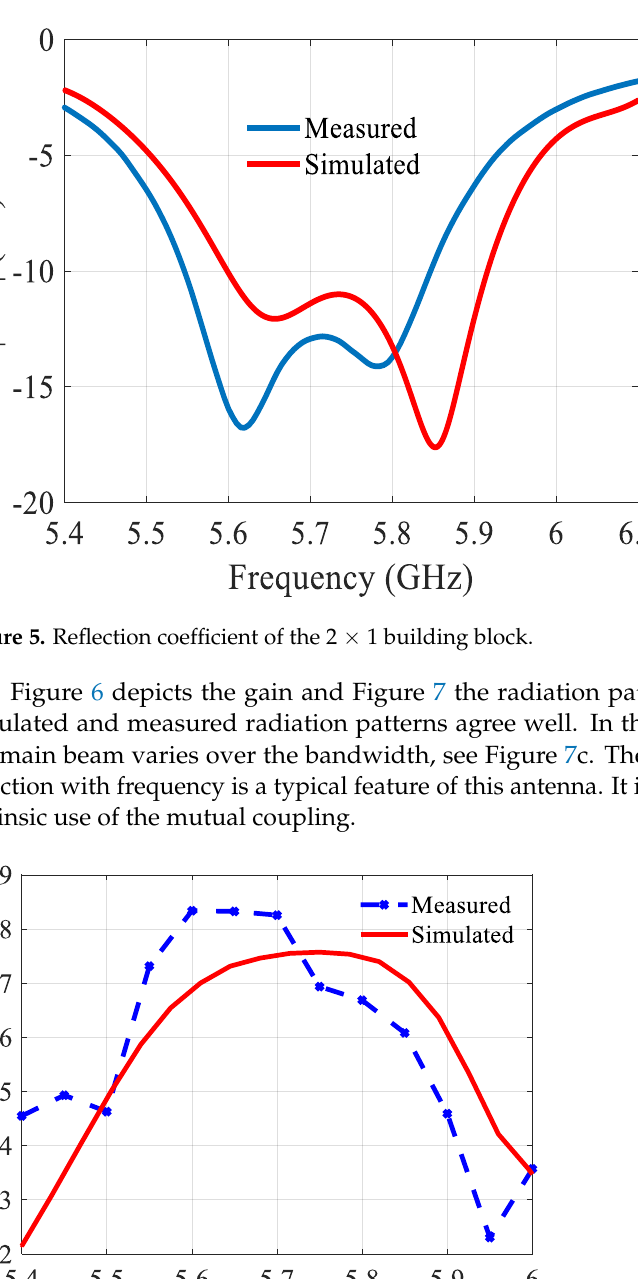
Figure 4. Prototype of the 2 × 1 building block.